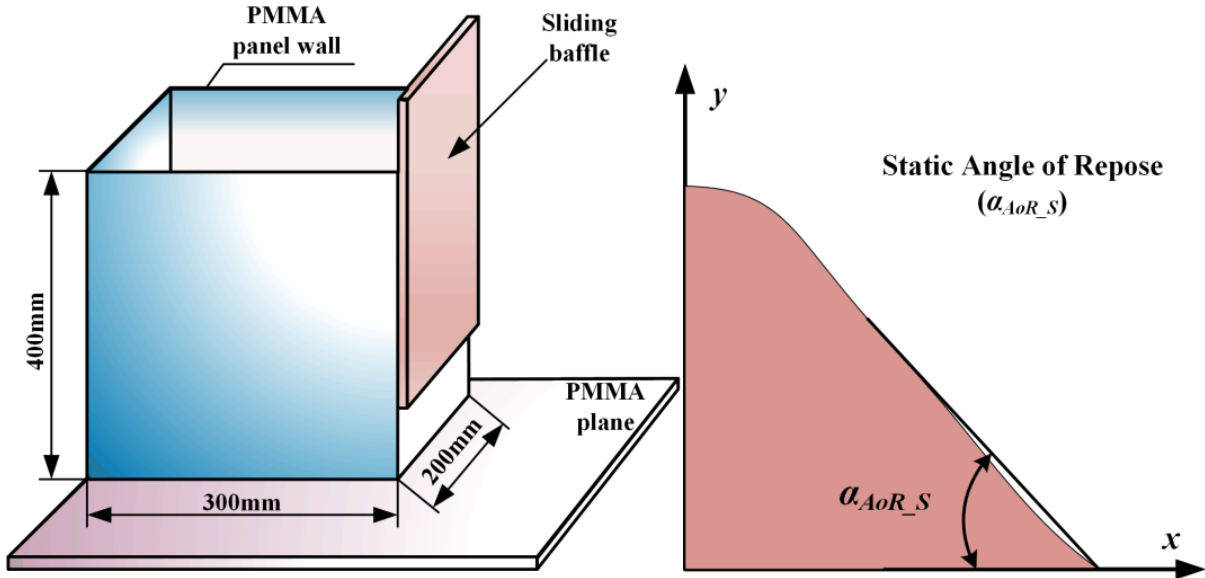
Figure 1. Principles of the baffle lifting test.